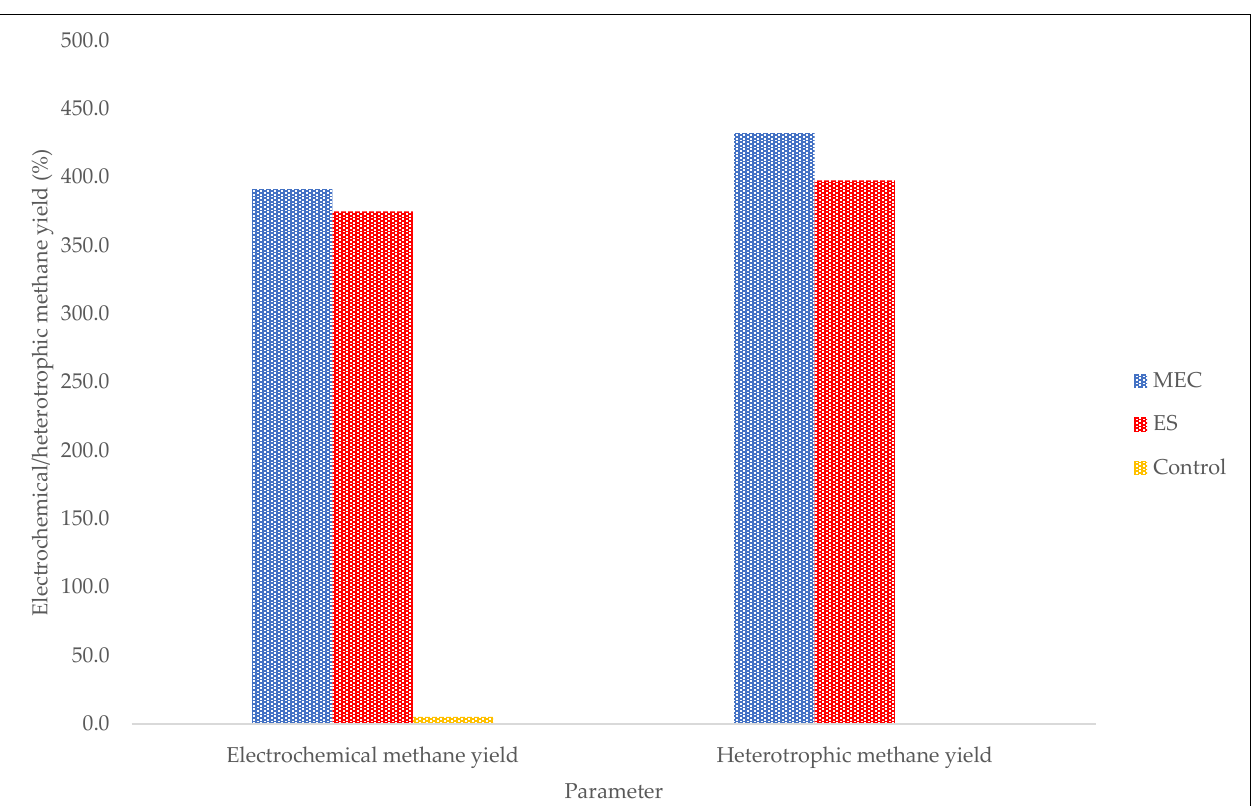
Figure 5. Electrochemical methane yield and heterotrophic methane yield with respect to digester type after the hydraulic retention period of 30 days.